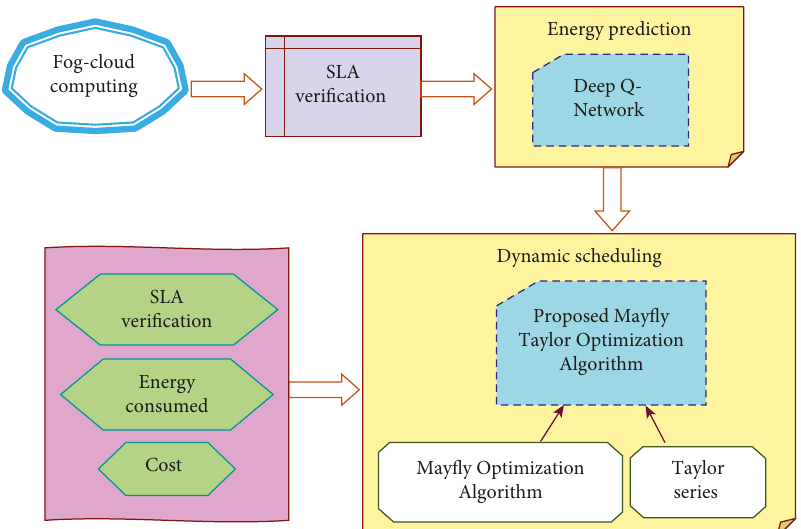
Figure 2: Overall architecture of dynamic scheduler model using MTOA-based